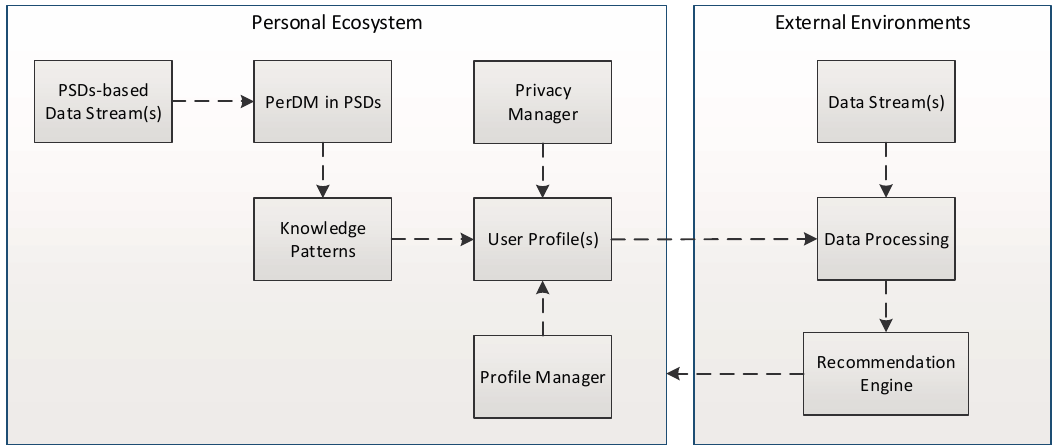
Figure 6. PSDs based user-centric personalization